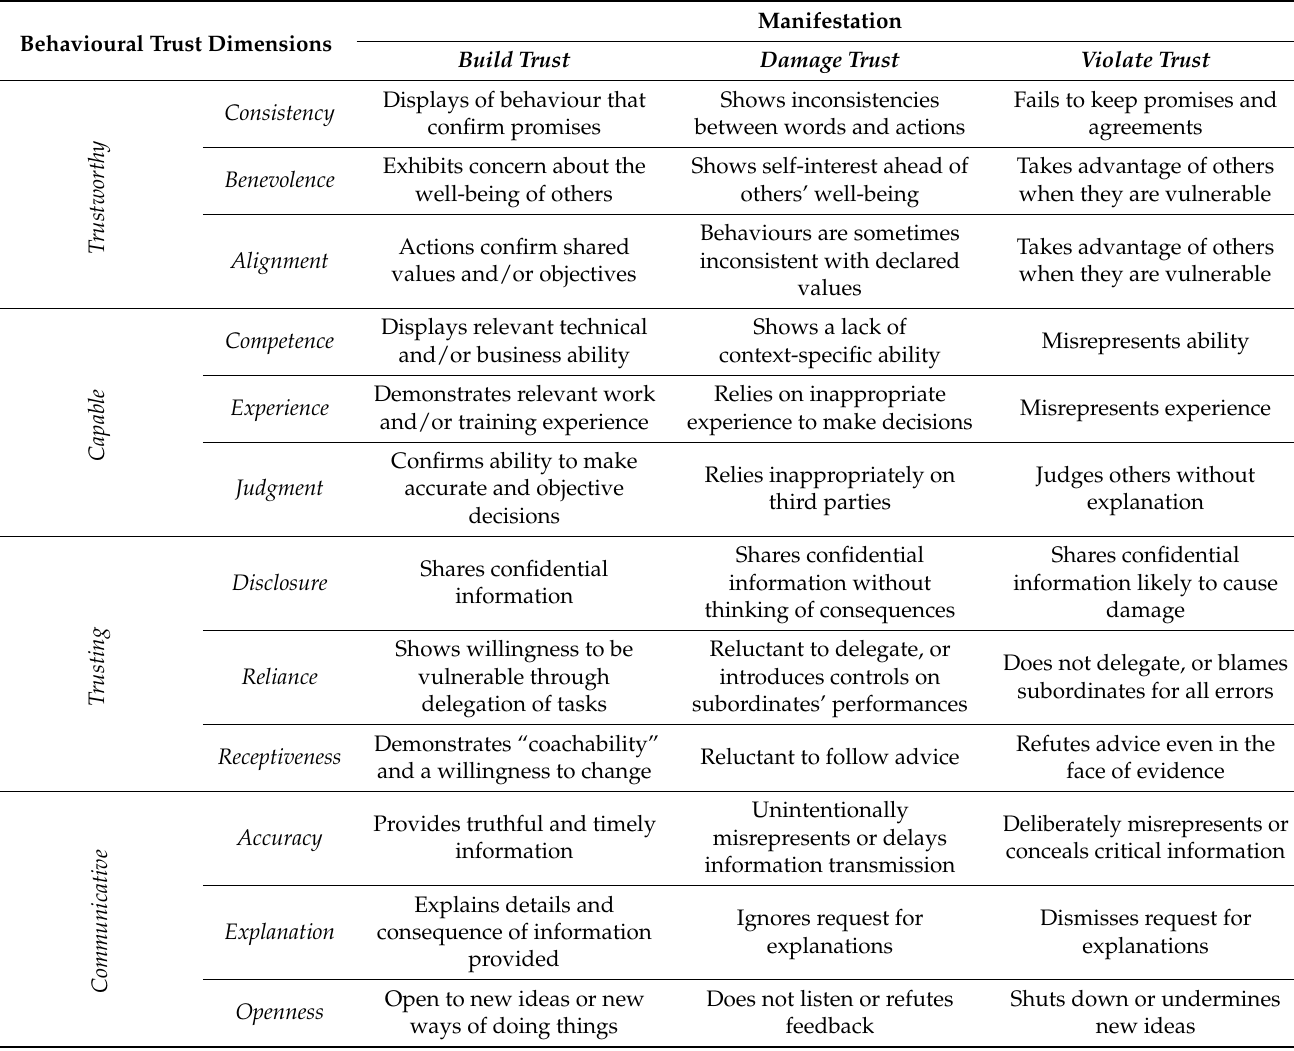
Table 3. Behavioral trust dimensions and manifestations. Source: adapted from Maxwell and L é vesque